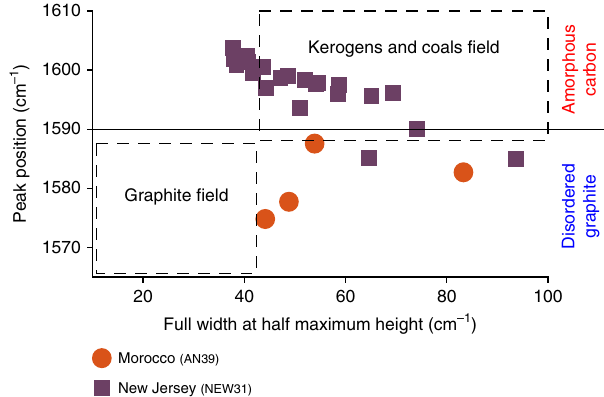
Fig. 6 Crossplot of the Raman spectra of elemental carbon. This crossplot displays the Raman spectra of elemental carbon with the peak position of the G band ranging from ca. 1575 cm − 1 to ca. 1605 cm − 1 . The line in correspondence of 1590cm − 1 peak position value separates the disordered graphite data (below) from the amorphous carbon data (above) according to the present study (see “ Methods ” section). The areas bordered by dashed lines distinguish the graphite fi eld from the kerogens and coals fi eld according to ref. 34 . The error on PP and therefore also on FWHM is considerably smaller than the spectral resolution for the Raman spectra displayed in the crossplot (0.8 cm − 1 ) 70 , and thus is much smaller than the plotted